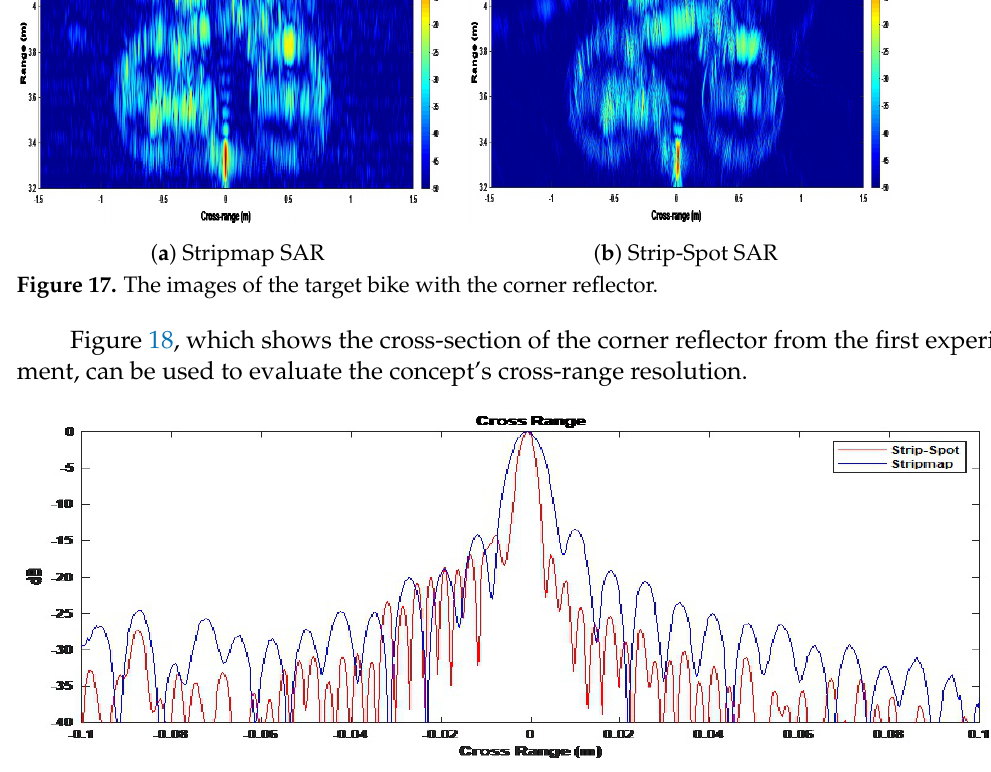
Figure 18. Cross-section of the cross-range of the corner reflector.